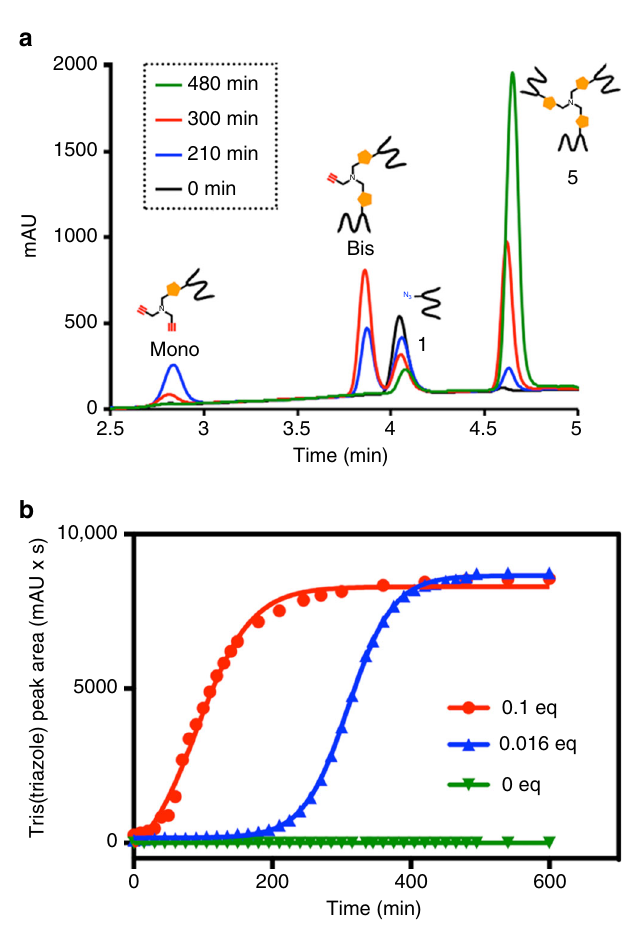
Fig. 3 Autocatalytic formation of oligotriazole peptide nanospheres. a HPLC traces (210 nm) monitoring the autocatalytic formation of tris(triazole) Boc- L - H Ala-OH ( 5 ) by cycloaddition reaction of tripropargylamine with the azidoderivative Boc- L - H Ala(N 3 )-OH.DCHA ( 1 ) in the presence of 0.016 equiv. of tris(triazole) 5 . The retention times for all the species were veri fi ed by mass spectrometry and the use of known standards. b Autocatalytic formation of tris(triazole) peptide 5 in the presence of 0, 0.016, or 0.1 equivalents of tris(triazole) peptide 5 . Sigmoidal growth curves are observed and can be fi t to a four-parameter logistic equation ( solid lines ), which are typically used to describe autocatalytic processes. HPLC spectra (210 nm) were used to monitor the progress of the CuAAC reaction. Retention times were veri fi ed by mass